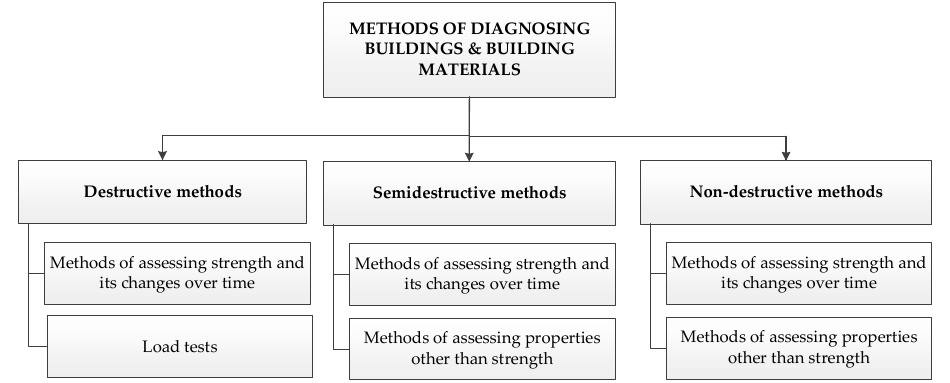
Figure 1. General classification of investigative methods useful for diagnosing buildings and building materials [2].